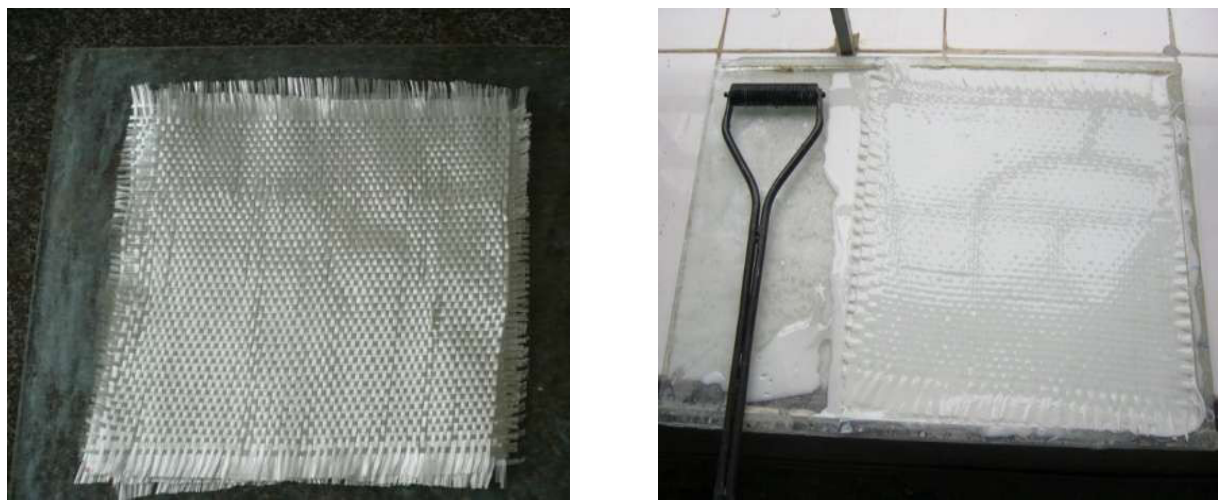
FIG. 6. FIBER GLASS/EPOXY/ELO SB